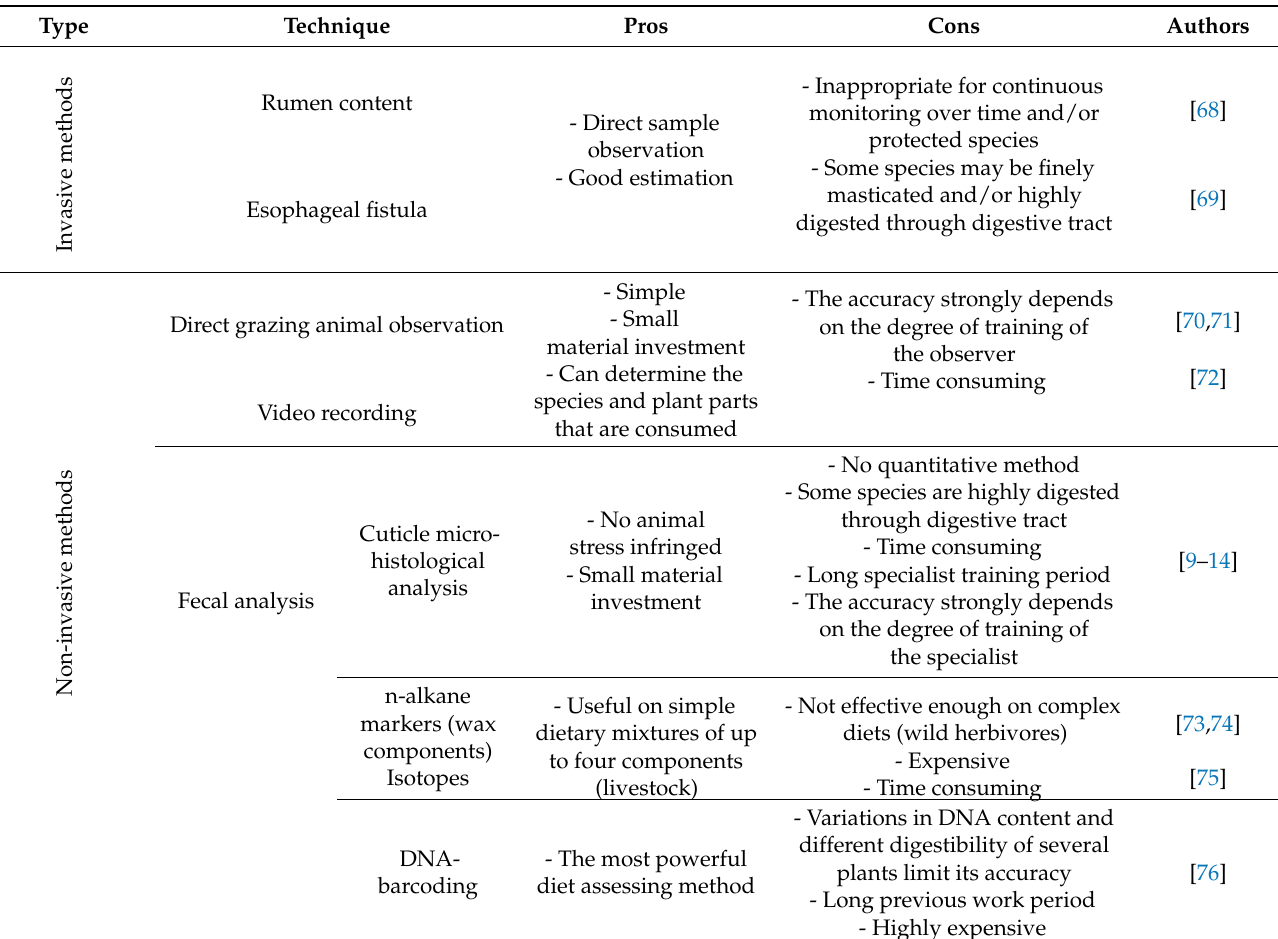
Table A1. Systematic review on the use of some diet composition determination methods for both, domestic and wild ruminants. In the column ‘Pros’ correspond to the advantages and in the column ‘Cons’ correspond to the disadvantages for each